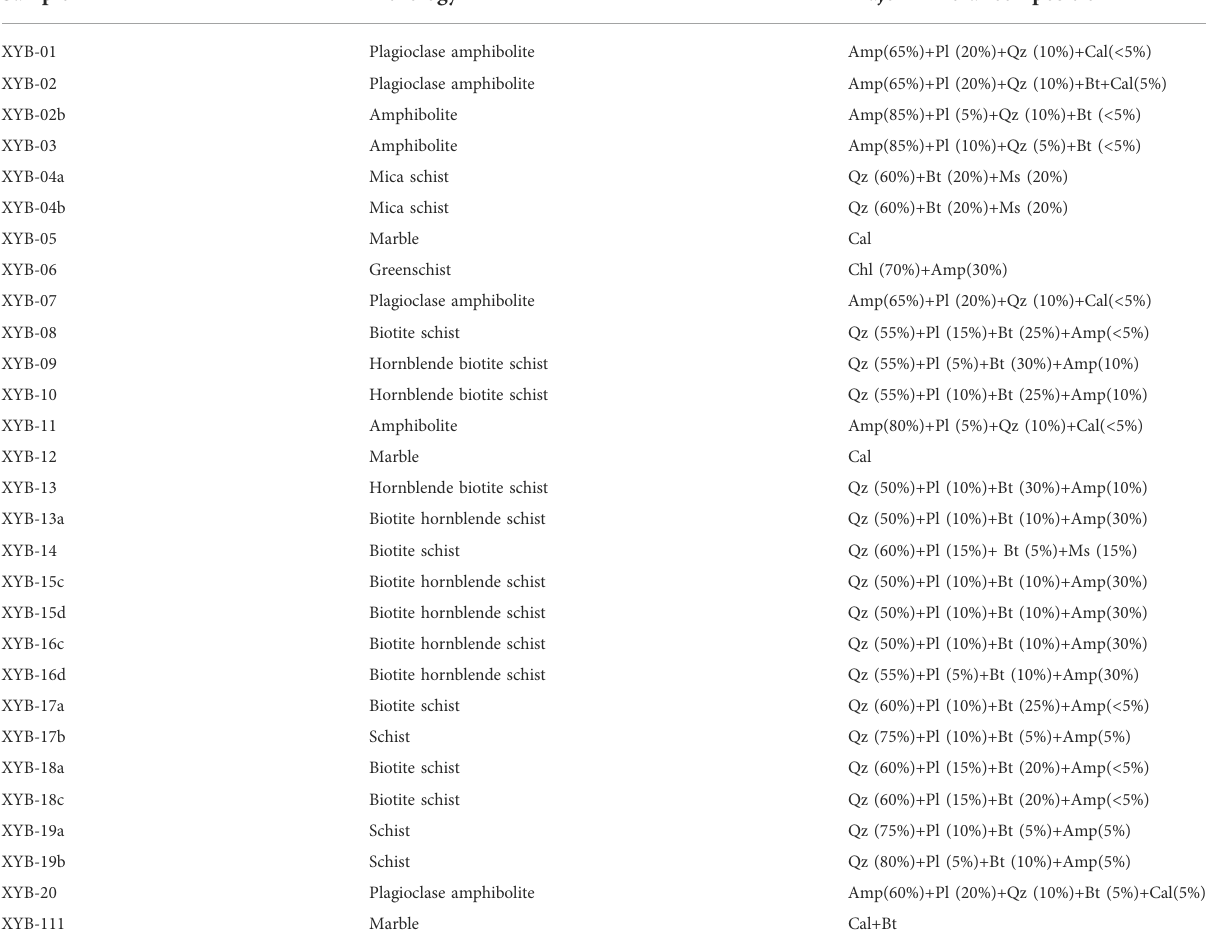
TABLE 1 Mineral assemblages of studied metamorphic rocks from the Xunyangba area.